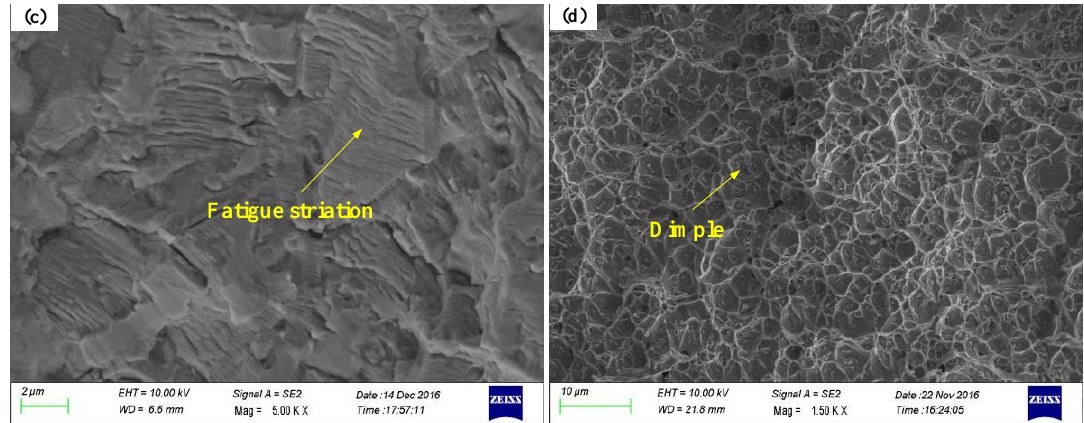
Figure 10. Fracture surface of FT specimen ( R a = 0.567 µm): ( a ) overview of fracture surface; ( b ) Crack nucleation site; ( c ) fatigue striations and ( d ) dimples.